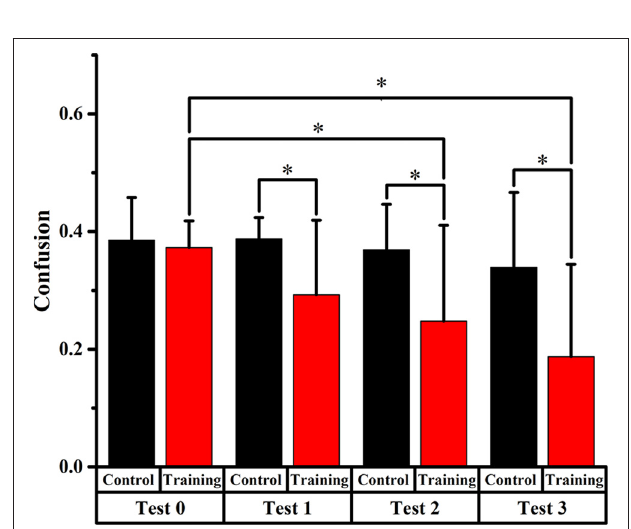
FIGURE 5 | Comparison of front-back confusion ratio for the audiovisual training and control groups between pre- and post-test at trained angles. ∗ meant the difference was significant ( P <